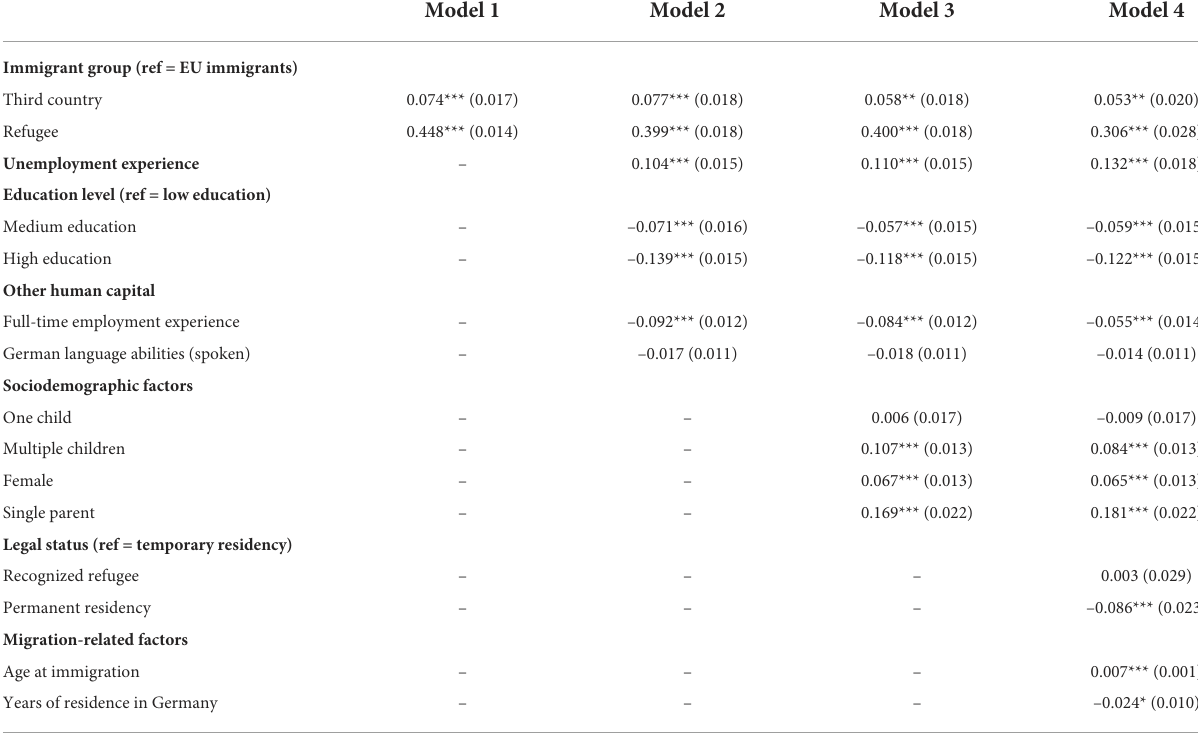
TABLE 3 Likelihood of welfare receipt of immigrants in Germany, marginal effects, stepwise modeling with full sample.